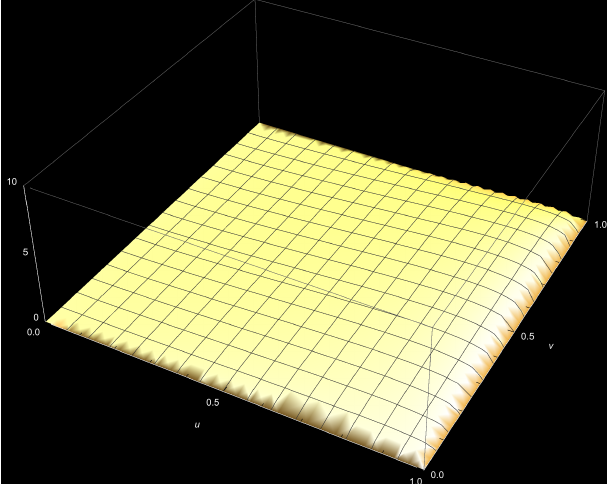
Figure A15. The bivariate Kumaraswamy density (Equation (1)) plot, where α = 1.1, β = 1.1, θ = 0.8 and δ =